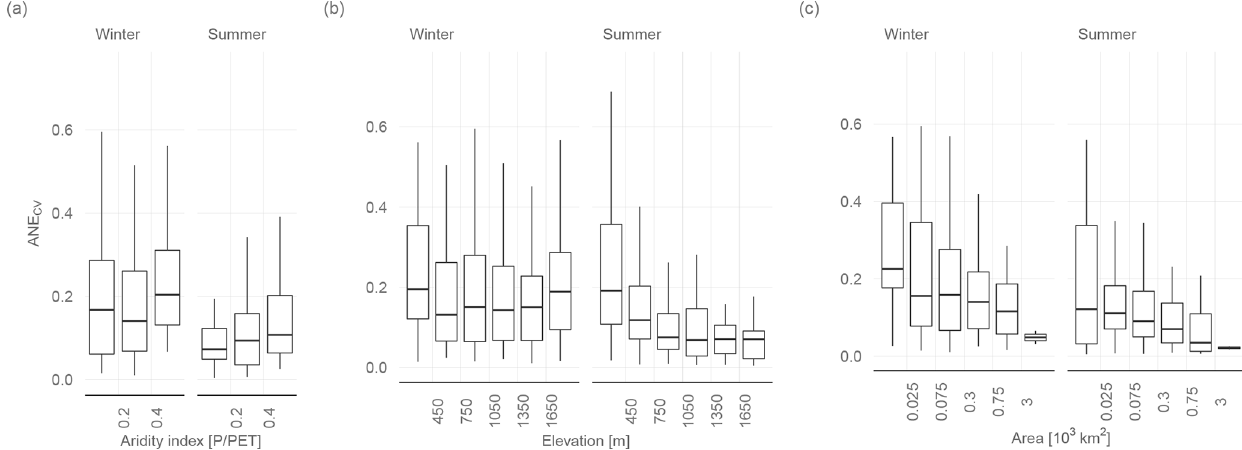
Figure 9. ANE CV for summer and winter q 95 as a function of the aridity index (a) , elevation (b) , and catchment area (c) . Only the best- performing models are shown (winter SVR, summer GAM, both without variable preselection). The box plots summarize the ANE CV averaged over all 10 CV runs for each of the 260